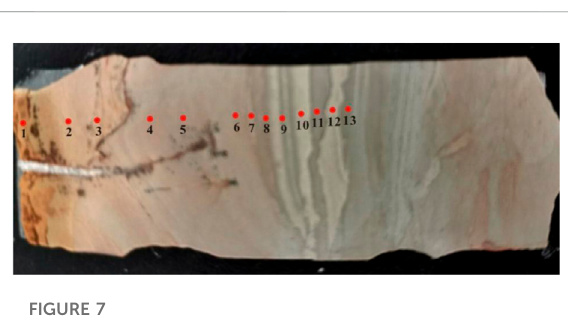
FIGURE 7 Locations of measurement points for the elemental analysis of concretion